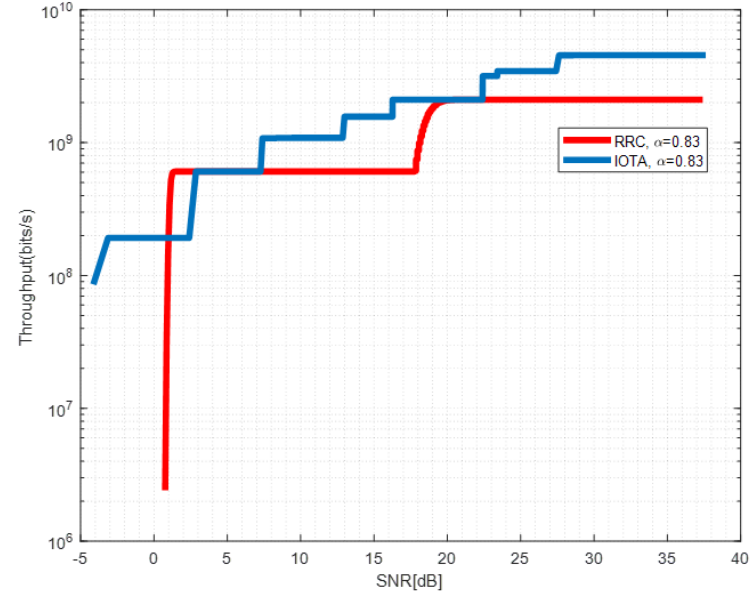
Figure 14. Throughput performance of IOTA and RRC with α =